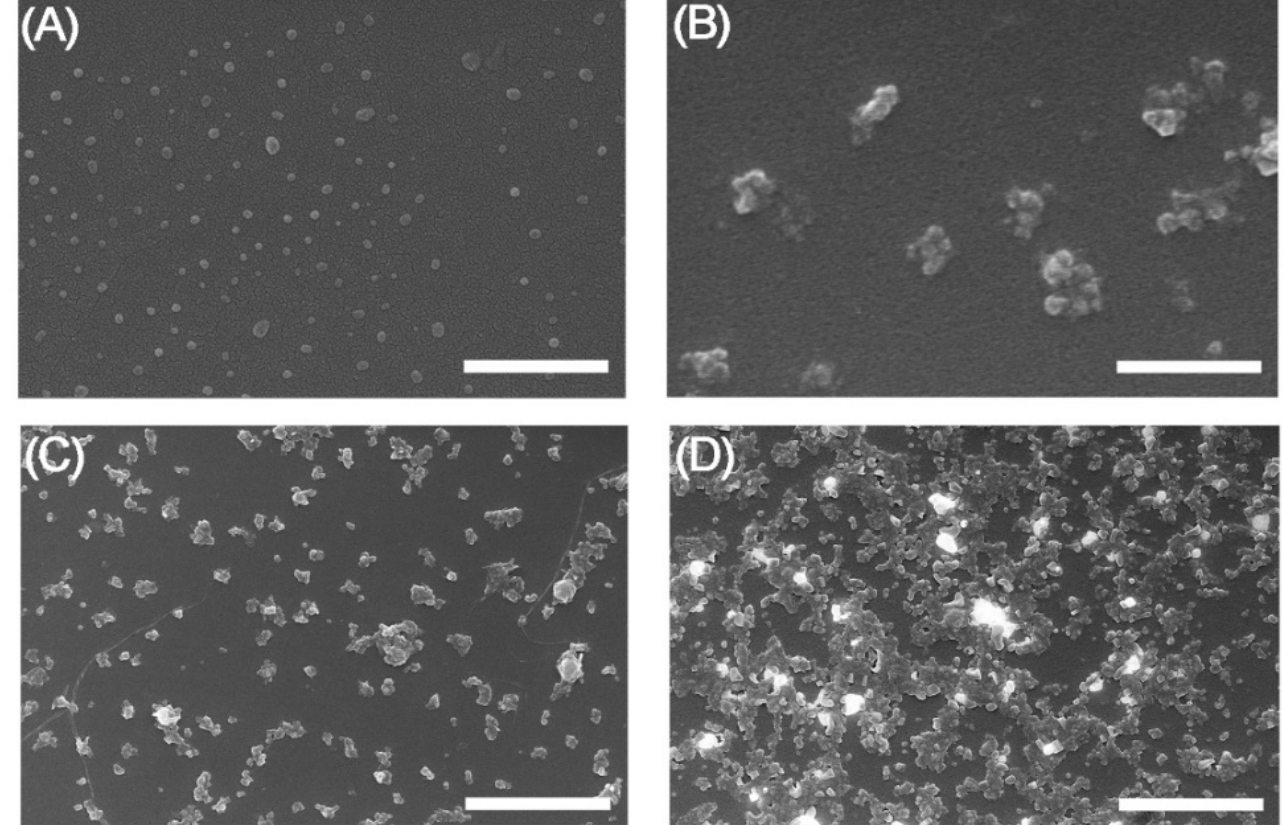
Figure 3. FESEM images of the NPs after incubation in serum: ( A ) SFN; ( B ) FITC-SFN; ( C ) [ 99m Tc]Tc- SFN; ( D ) [ 99m Tc]Tc-FITC-SFN. Scale bars = 500 nm, ( A , B ); 2 μ m, ( C , D ).